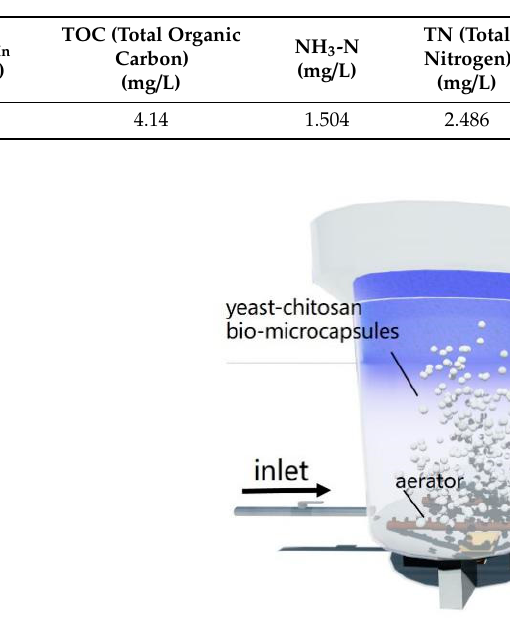
Table 1. Water quality index of Sanhaowu River.